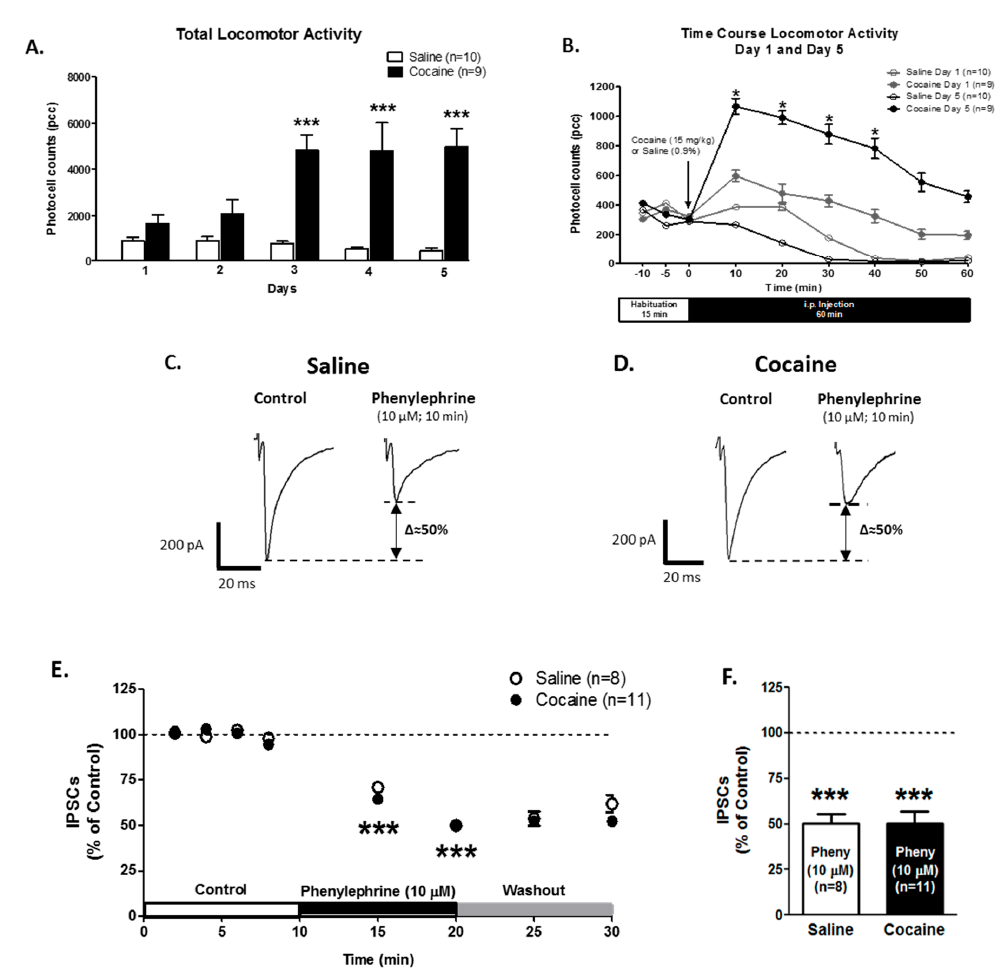
Figure 6. α 1-ARs-mediated GABA A IPSCs e ff ect is present in VTA DA neurons from cocaine-sensitized animals. ( A ) A bar graph showing total locomotor activity recorded from saline- (0.9%, white bars; n = 10) and cocaine- (15 mg / kg i.p., black bars; n = 9) treated animals. Cocaine-injected animals showed a progressive increase in locomotor activity over 5 days. On days 3, 4, and 5, the total activity was significantly increased when compared to day 1 in cocaine-treated animals (Two-way repeated measures ANOVA, Bonferroni post hoc test, p < 0.001). ( B ) The time course of locomotor activity on days 1 (grey) and 5 (black) of cocaine- (15 mg / kg, i.p.) (filled) or saline- (unfilled) treated animals. Cocaine sensitization was manifested as an increase in locomotor activity during the first 10–40 min after cocaine injection in comparison with day 1. The data (pcc / 60 min; Mean ± SEM) were analyzed by Two-way repeated measures ANOVA, Bonferroni post hoc test ( p < 0.05). ( C , D ) Representative recordings from saline- and cocaine-treated animals, respectively, illustrate that phenylephrine superfusion (10 µ M, 10 min) induces a significant reduction on GABA A IPSCs amplitude in VTA DA neurons from saline- and cocaine-treated animals. ( E ) The time course summary of the e ff ects of phenylephrine bath application on GABA A IPSCs amplitude, recorded from 8 VTA DA neurons from saline-treated animals and 11 VTA DA neurons from cocaine-treated animals at 8 min of control (2 min intervals), 5 and 10 min phenylephrine (10 µ M), and 5 and 10 min washout. A 10 min phenylephrine application increases the GABA A IPSCs amplitude in neurons from saline- and cocaine-treated animals (One-way ANOVA, Newman-Keuls post hoc test, p < 0.001). ( F ) A Bar graph showing that, in neurons from saline- ( n = 8 / 10) and cocaine- ( n = 11 / 9) treated animals, phenylephrine application resulted in a ~50% reduction on GABA A IPSCs amplitude (One-way ANOVA, Newman-Keuls post-hoc, p < 0.001). * p < 0.05; *** p < 0.0001. n = the number of cells recorded / number of